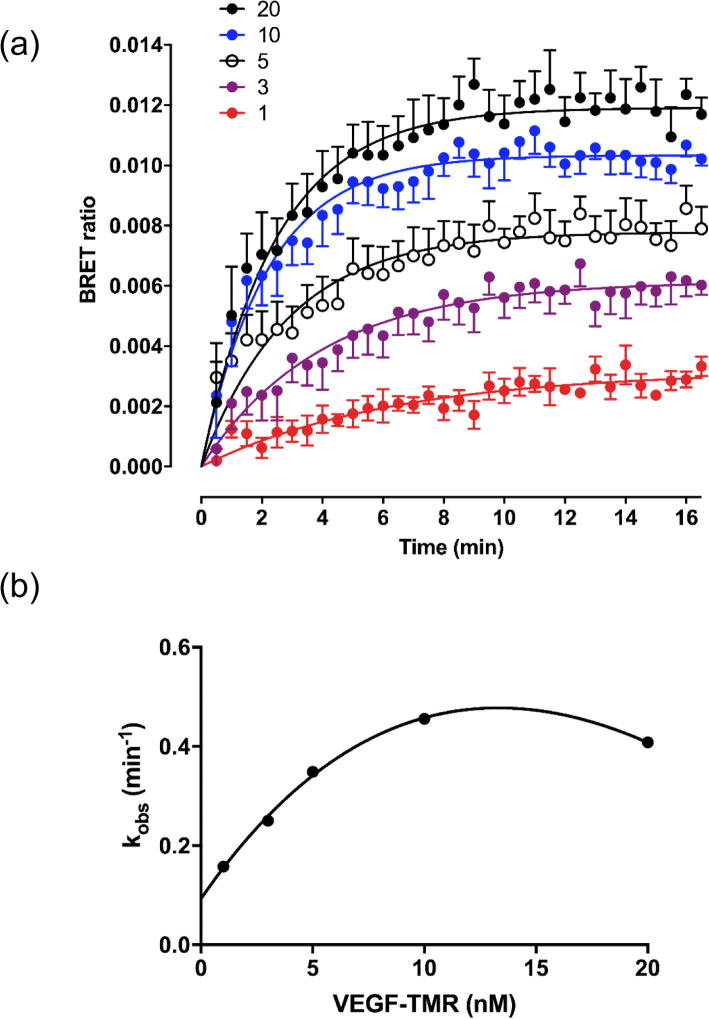
Ligand binding kinetics of VEGF165a-TMR to VEGFR2. (a) Time course of VEGF165a-TMR binding to NLuc-VEGFR2. HEK293T cells expressing NLuc-VEGFR2 were treated with furimazine and the plate left to equilibrate for 5 min. Vehicle or VEGF165a-TMR (1–20 nM; coloured symbols) was then added to the appropriate wells, and measurements made every 30 s for 16 min at 37 °C. Data represent mean ± S.E.M from 5 independent experiments. Individual curves were fitted to a simple exponential association model to obtain Kobs. (b) A plot of Kobs values obtained in (a) with increasing concentrations of VEGF165a-TMR.